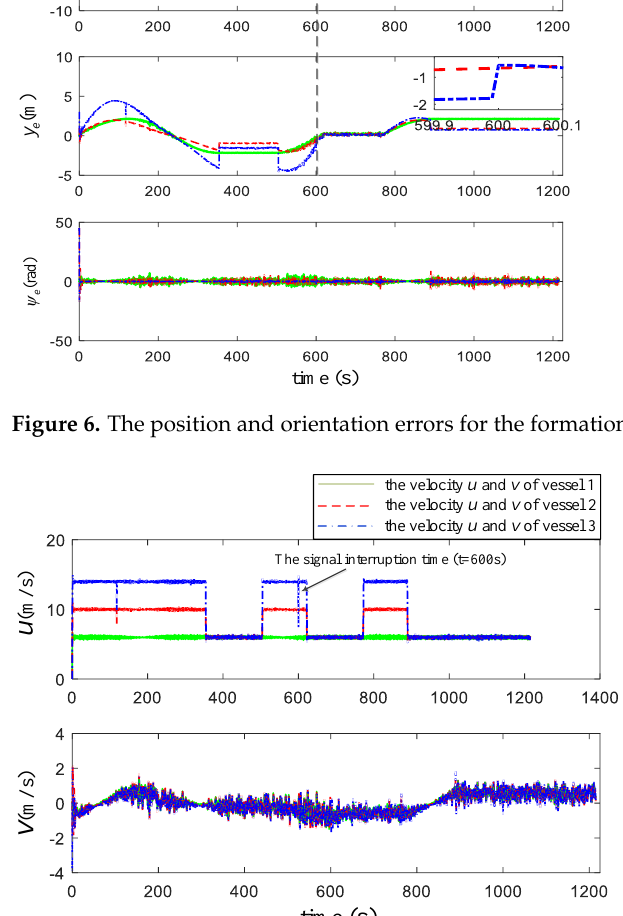
Figure 7. The change in surge velocity and sway velocity in vehicle navigation.